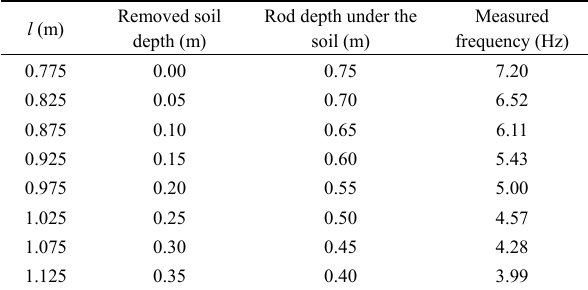
Table 4 Experimental data record.